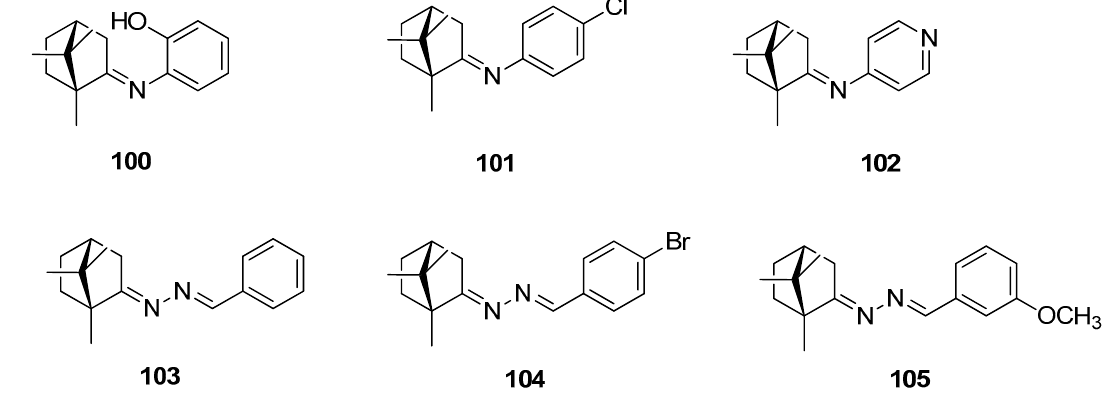
Figure 26. (+)-Camphor imine and hydrazone derivatives. Figure 26. ( + )-Camphor imine and hydrazone derivatives.